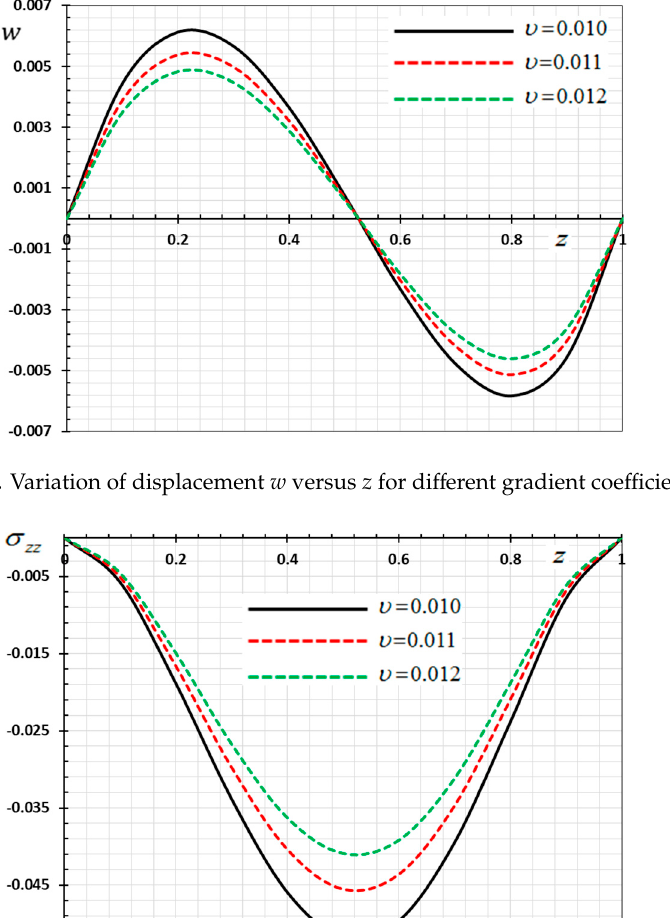
Figure 13. Variation of temperature 𝜃 versus 𝑧 for different velocity of the heat source 𝜐 .